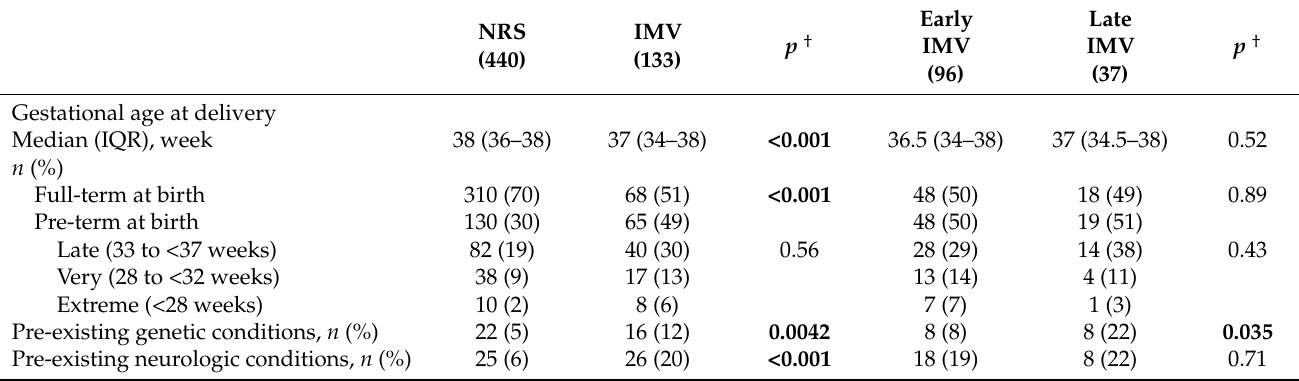
Table 2. Clinical Characteristics (all groups, n = 573).